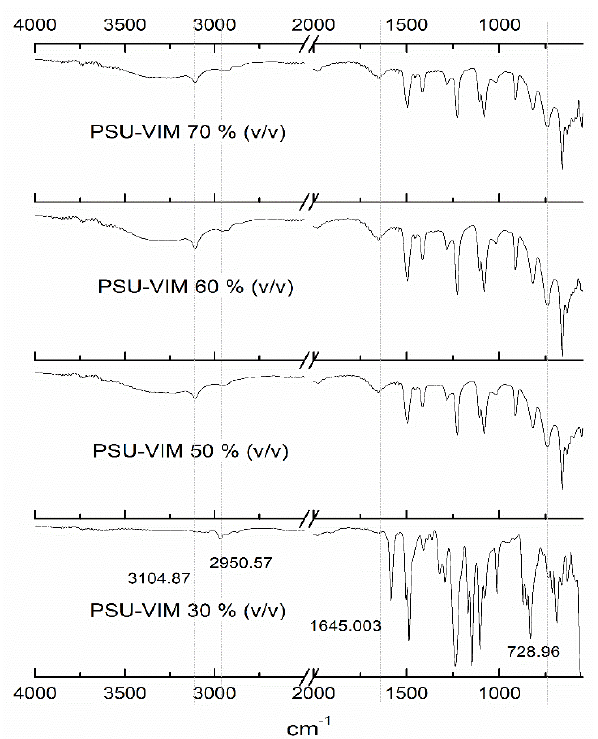
Figure 3. FTIR spectra of the grafted PSU membranes with VIM at different concentrations 30%-70% and gamma irradiation absorption dose of 300 kGy.